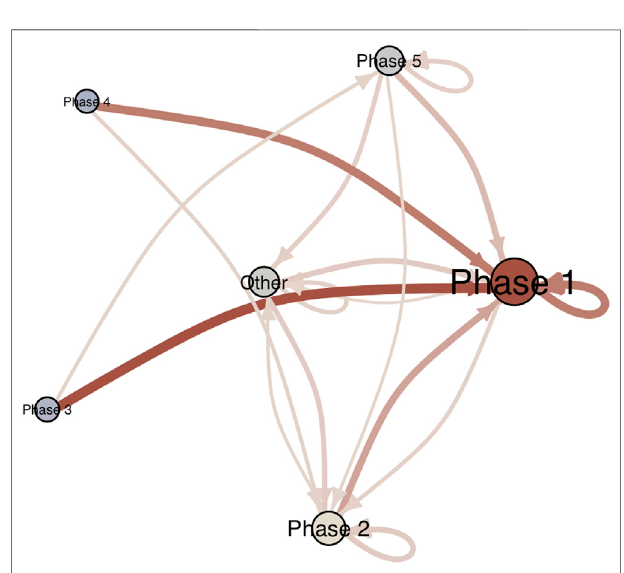
FIGURE 13 | Transition Network of the phases of the subsystem Day. Edges with a transition probability below 0.10 are not displayed.